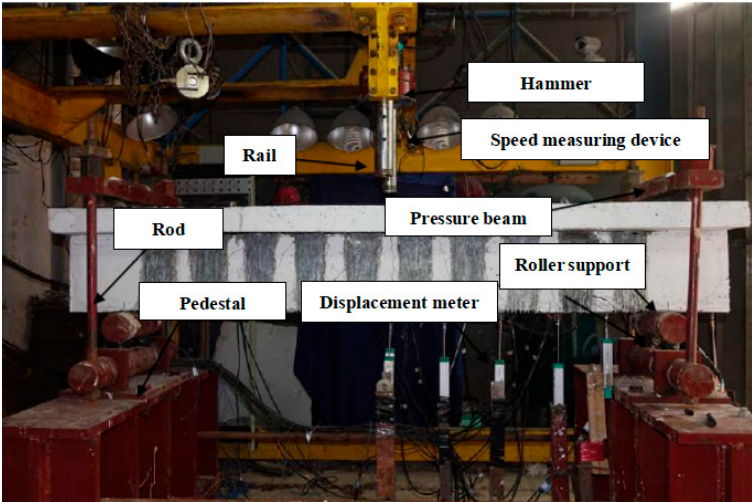
Figure 1. Details of the tested beam (obtained from Liu [22]). ( a ) Cross-section size and rebar arrangement. ( b ) Strengthening details for the beam.